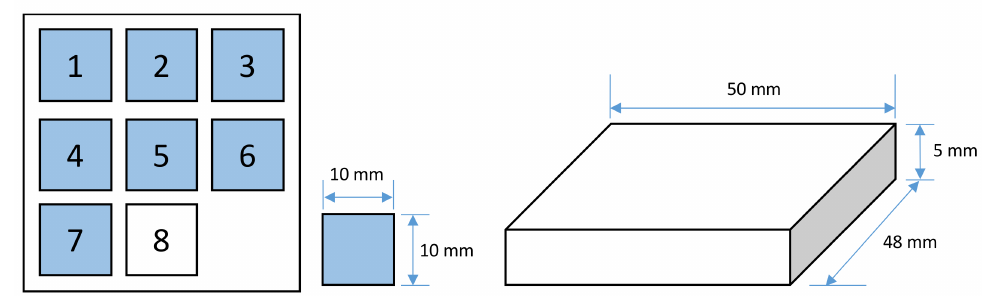
Figure 1. Dimensions and layout of textured